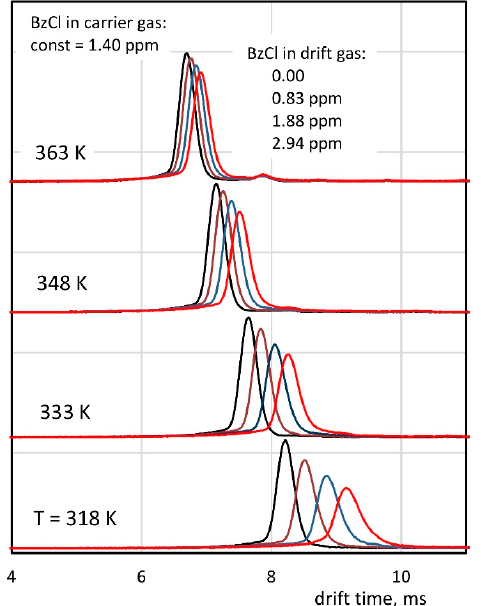
Figure 6. The effect of the peak shift with the introduction of the sample into the drift gas. All measurements were made with a BzCl concentration in the carrier gas of 1.40 ppm.